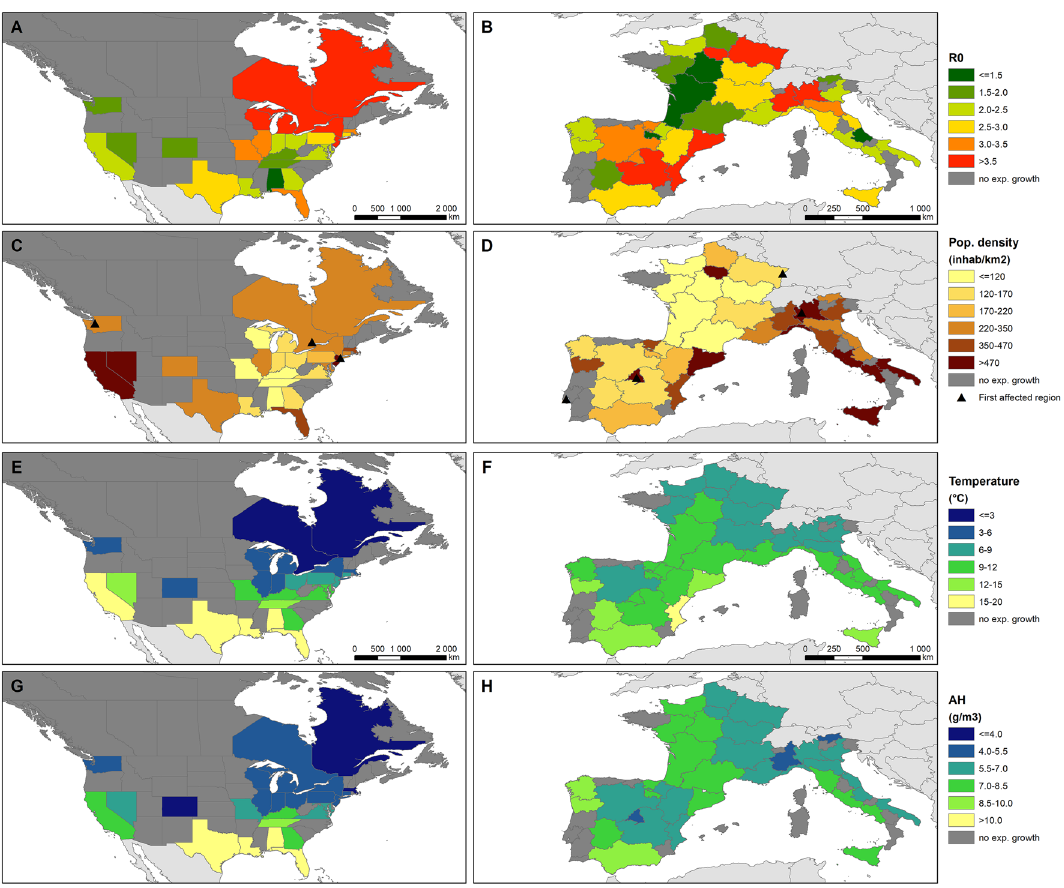
Figure 3. Map of regional values for R 0 and selected covariates, panels are presented by continent. ( A , B ) R 0 , ( C , D ) population density (inhabitants per km 2 ) and first region affected with 10 cumulative deaths, ( D , E ) mean